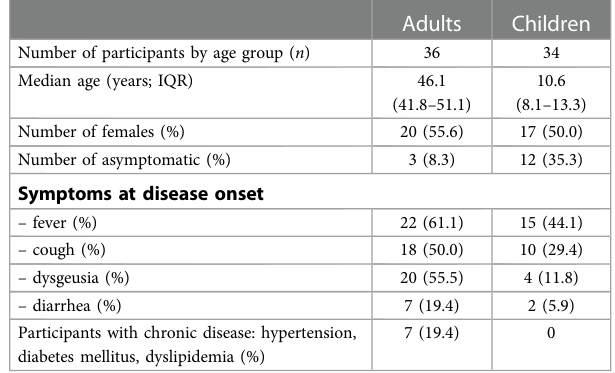
TABLE 1 Demographics and key information on the study participants. Samples were taken 114 days (IQR 109 – 120; T1) and 340 days (IQR 322 – 356 days; T2) post COVID-19 symptom onset. Only participants who were seropositive at T1 and T2 and showed neutralization capacity against ancestral Wuhan strain at T1 were included; this study concentrates on the analysis of the results at the later (T2) timepoint. Individuals vaccinated against SARS-CoV-2 were excluded. See methods for de fi nition of how samples were de fi ned as being seropositive, asymptomatic or symptomatic. Abbreviations: IQR, interquartile